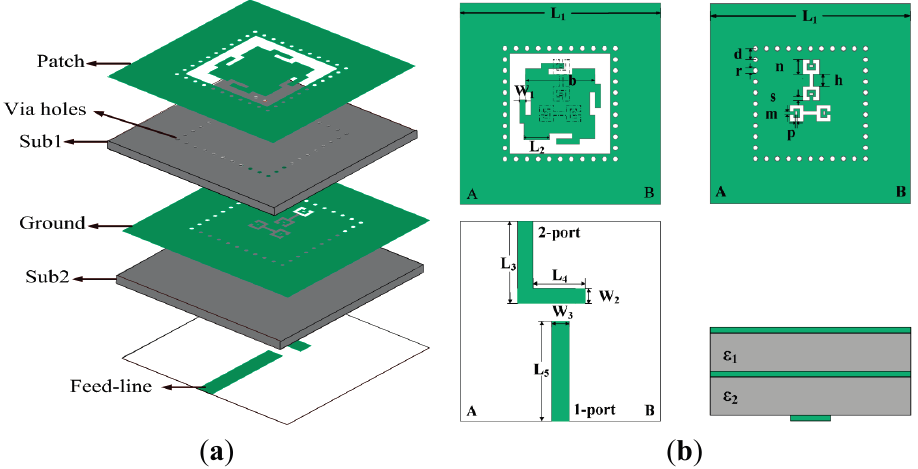
Figure 1. Con fi guration of the proposed antenna: ( a ) 3-dimensional view; and ( b ) top and side view of each metallic layer. ( L 1 = 40 mm, L 2 = 4.6 mm, L 3 = 16.5 mm, L 4 = 11.5 mm, L 5 = 20 mm. W 1 = 1.1 mm, W 2 = 3 mm, W 3 = 3.4 mm, b = 13.9 mm, d = 2.2 mm, r = 0.3 mm, n = 2.9 mm, h = 2.5 mm, s = 0.8 mm, m = 0.7 mm, p = 0.4